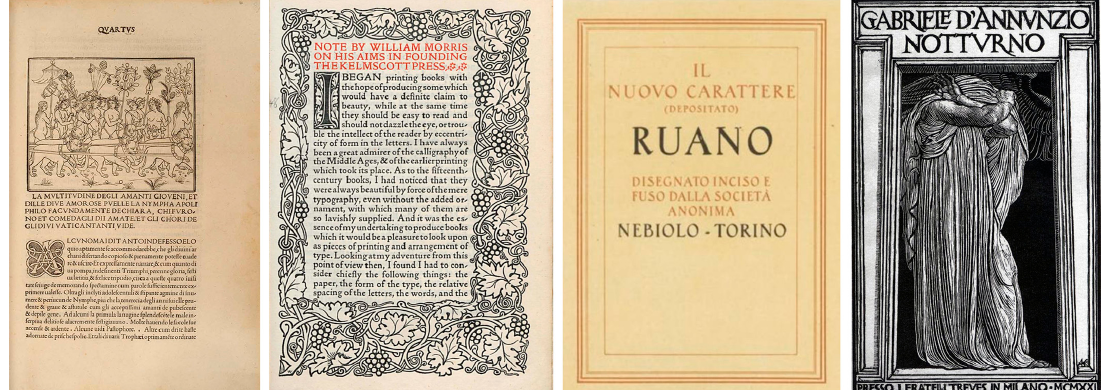
Figure 3. The references. Manuzio, Hypnerotomachia Poliphili , Venice, 1499; William Morris, A Note by William Morris on His Aims in Founding the Kelmscott Press , Hammersmith: Kelmscott Press, 1898;